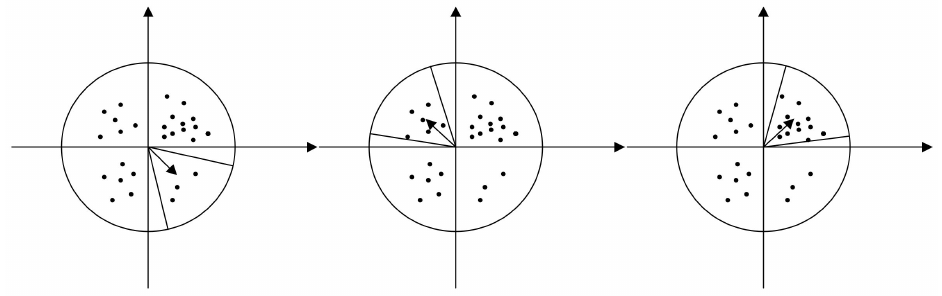
Figure 3. AKAZE calculates feature direction.